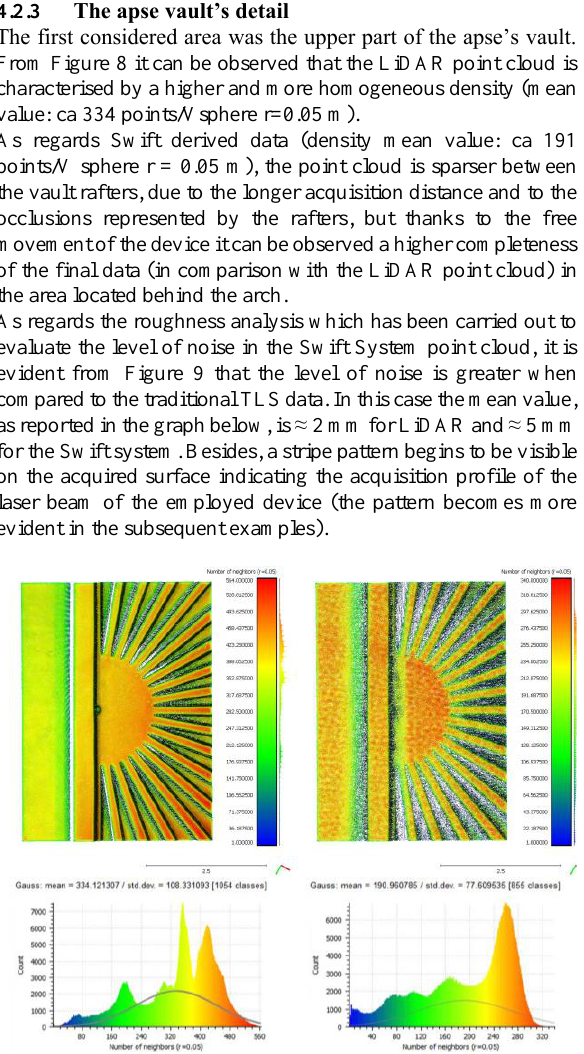
Figure 8. Upper part of the apse, density comparison between TLS (left) and MMS (right). The analysis has been performed using CC (number of neighbour analysis, pts/V sphere r = 0.05 m).